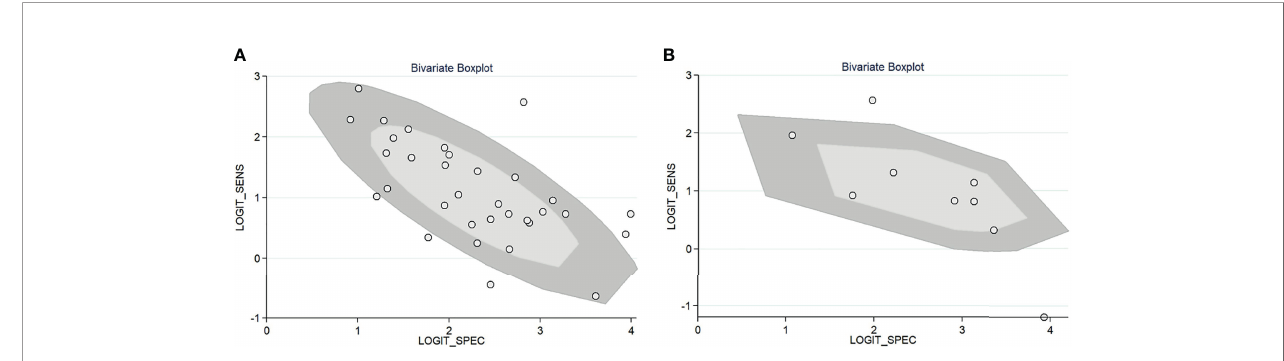
FIGURE 7 | Bivariate boxplot of the sensitivity and speci fi city in the included studies. (A) Gadoxetic acid-enhanced MRI. (B) ECA-MRI. ECA, extracellular contrast